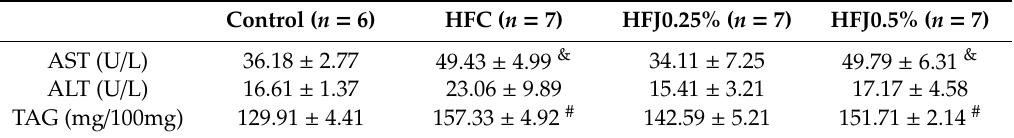
Table 3. Hepatic enzymes analyzed in serum and liver ectopic triacylglycerol